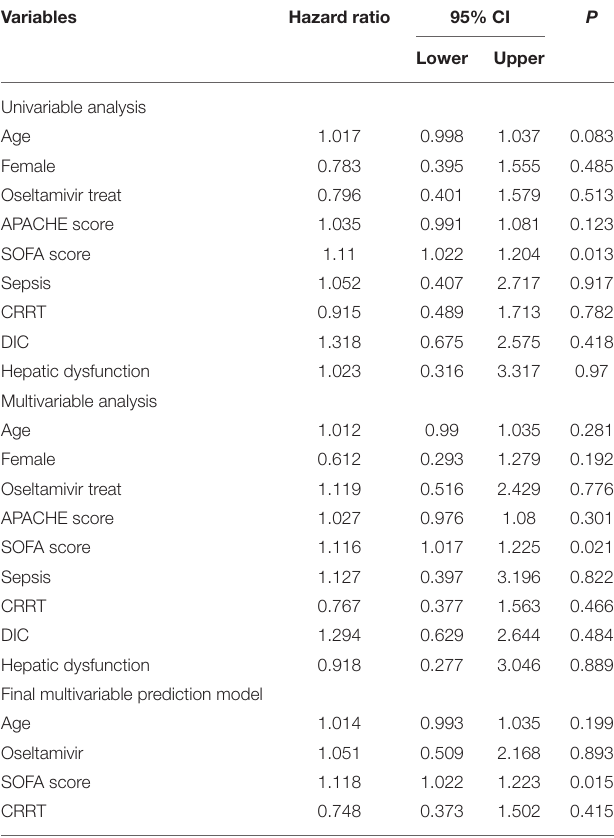
TABLE 4 | Multivariate Cox proportional hazard analysis of factors influencing survival in all patients who received